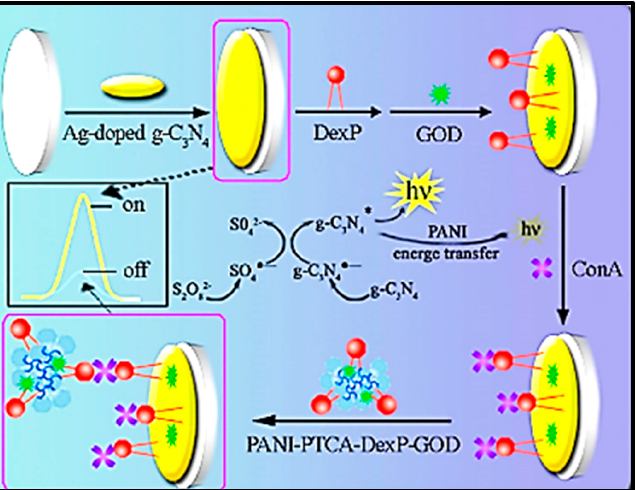
Figure 5. The functionalized Ag-g-C 3 N 4 and PANI-PTCA-DexP-GOD for the ECL biosensor [48].